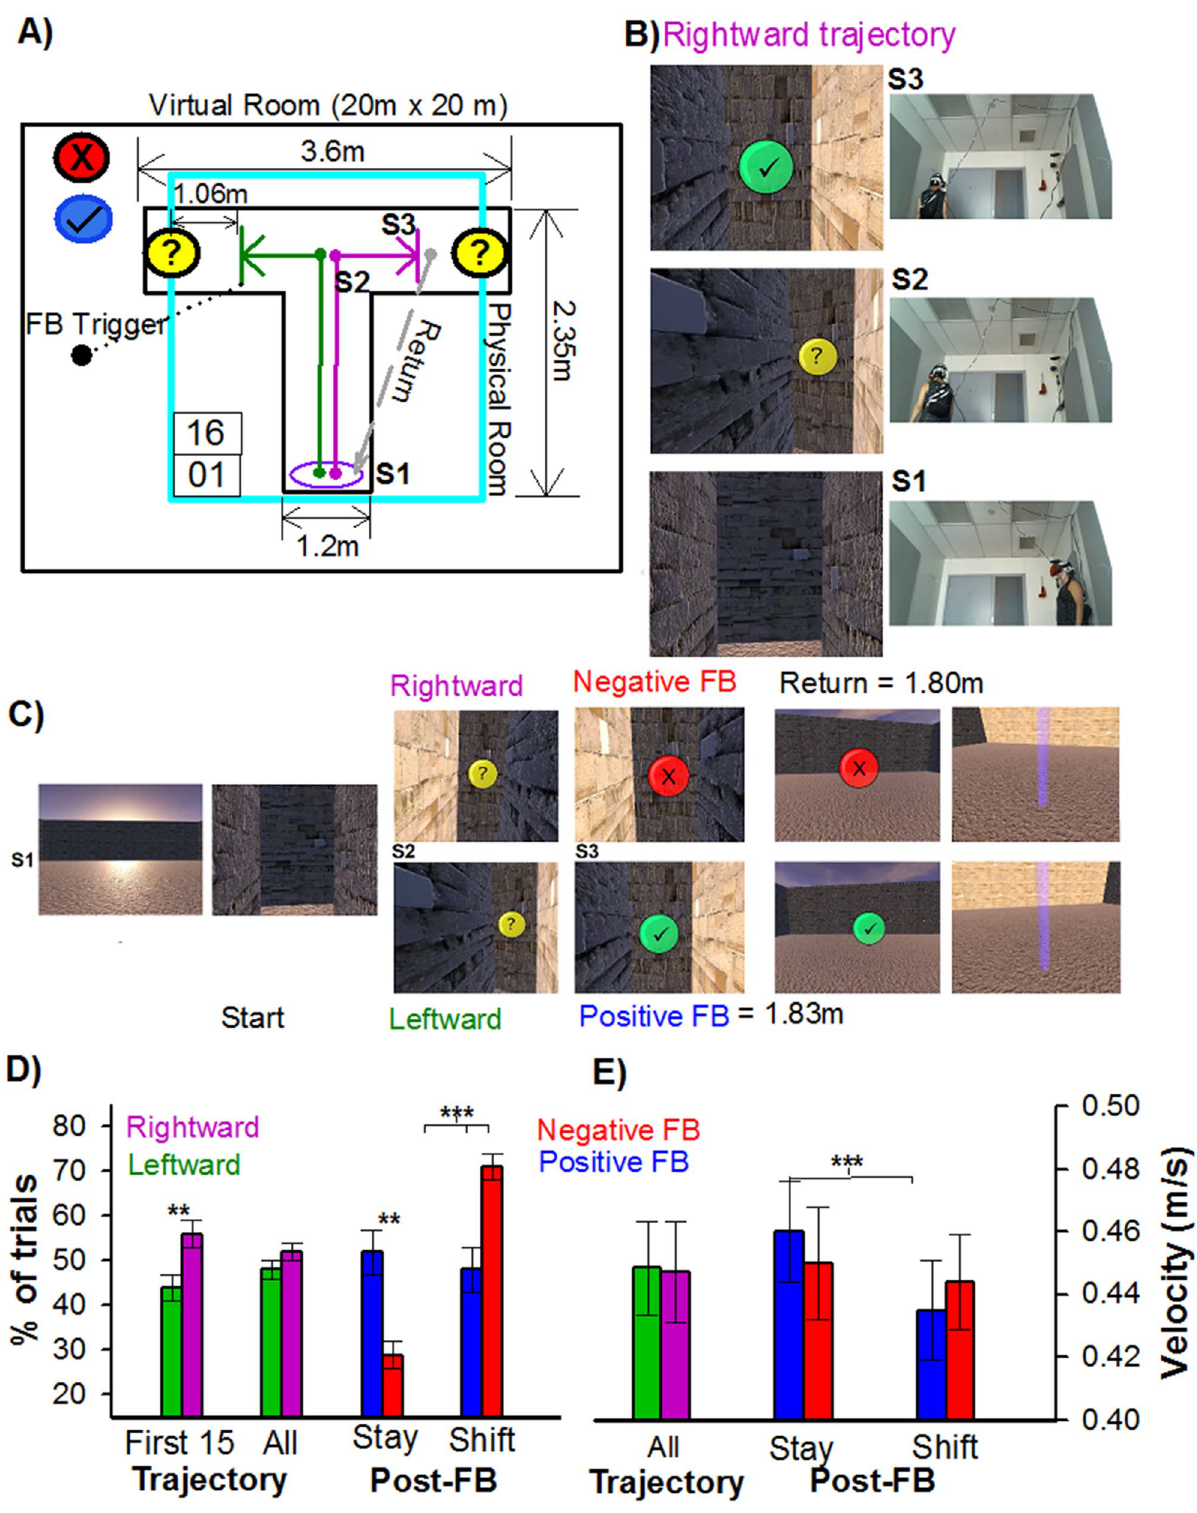
Figure 1. Mobile virtual reality T-maze paradigm and associated behavior. ( A ) Dimensions of the virtual (black border) and physical (cyan border) room and T-maze (S1: start location, S2: junction point, S3: feedback location). Purple and green lines denotes rightward and leftward trajectories, respectively. ( B ) An example of a rightward trajectory in the T-maze, ( C ) and trial-to-trial sequence of events. Behavioral analysis for choice ( D ) and velocity ( E ). Green and purple bars denote leftward and rightward trajectories, and Blue (positive) and Red (negative) bars denote post-feedback